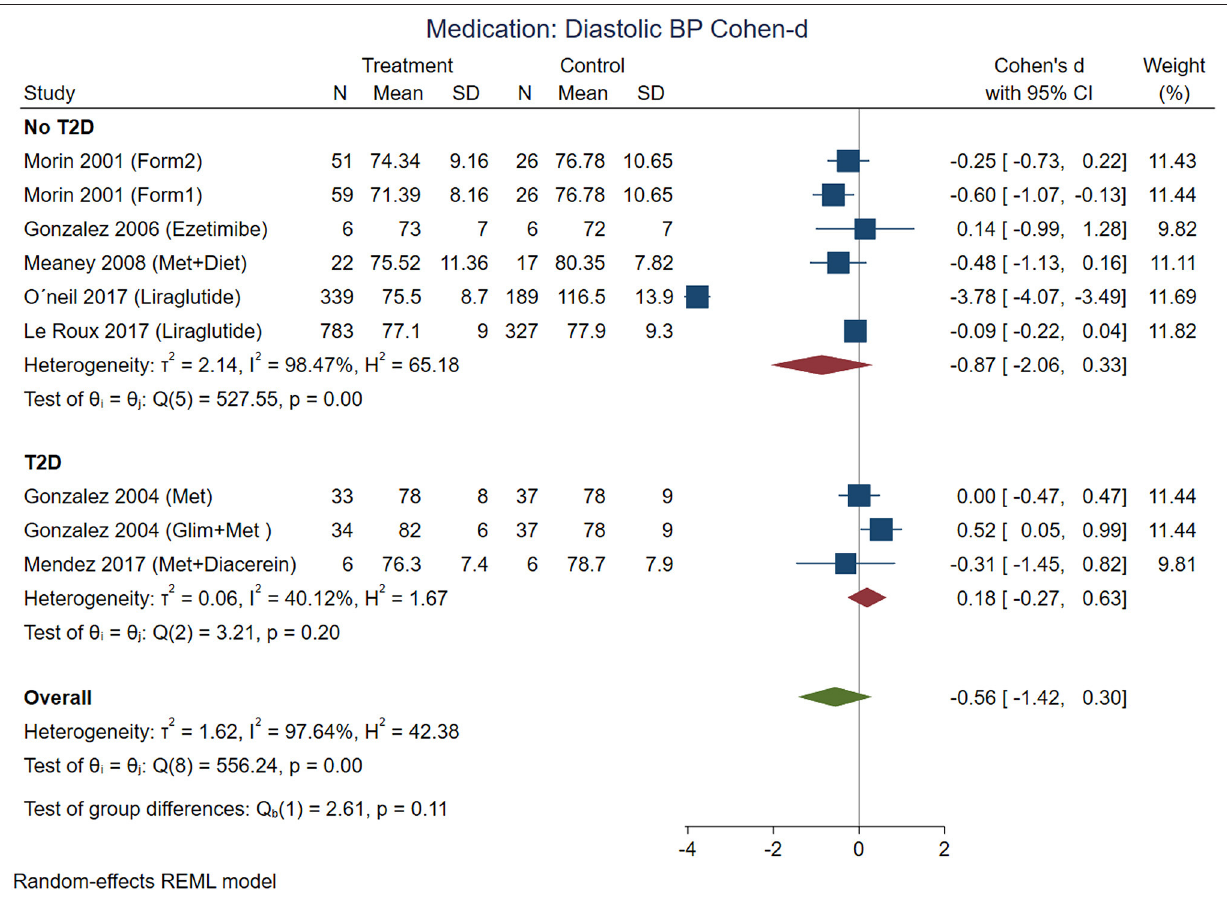
FIGURE 10 | Pooled analysis of Cohen’s d-weighted effect size onof effect by Cohen-d in diastolic blood pressure with drug (medication) treatment. The analysis was stratified by T2D status. The Form1 and Form2 are described in the text, they are not approved by FDA but approved by its Mexican counterpart, COFEPRIS.